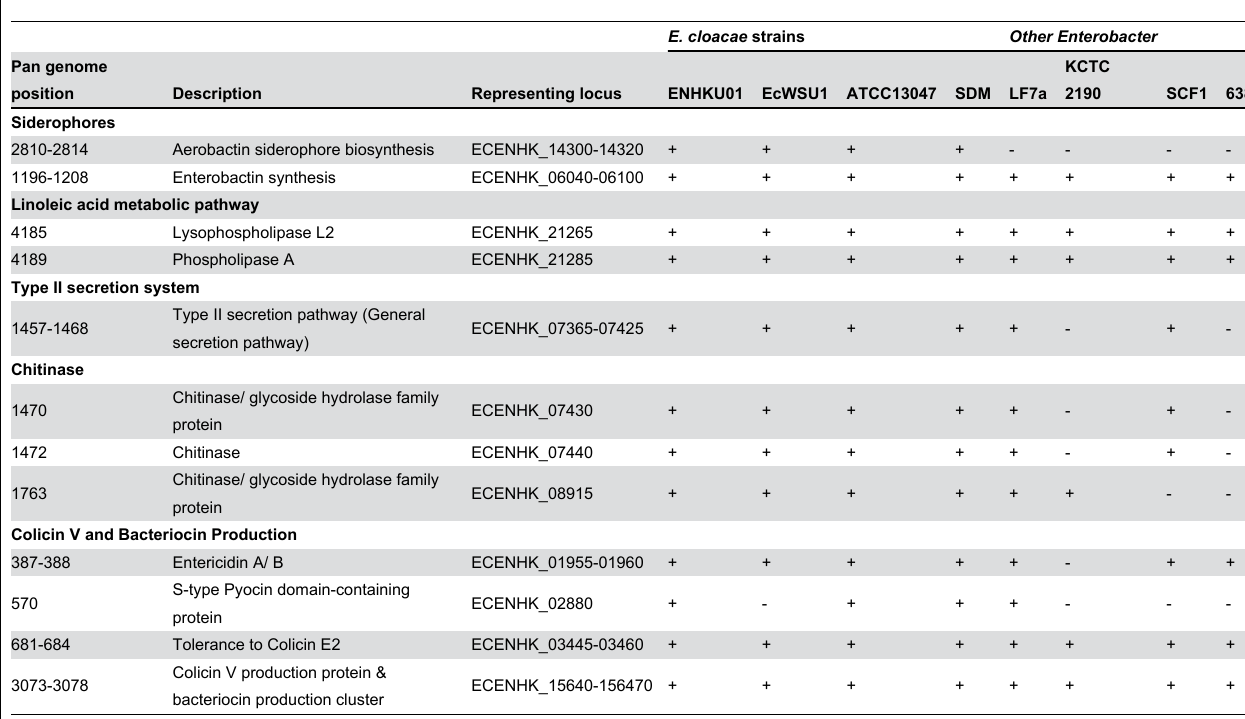
Table 3. Key genes involved in potential antagonistic activities in Enterobacter